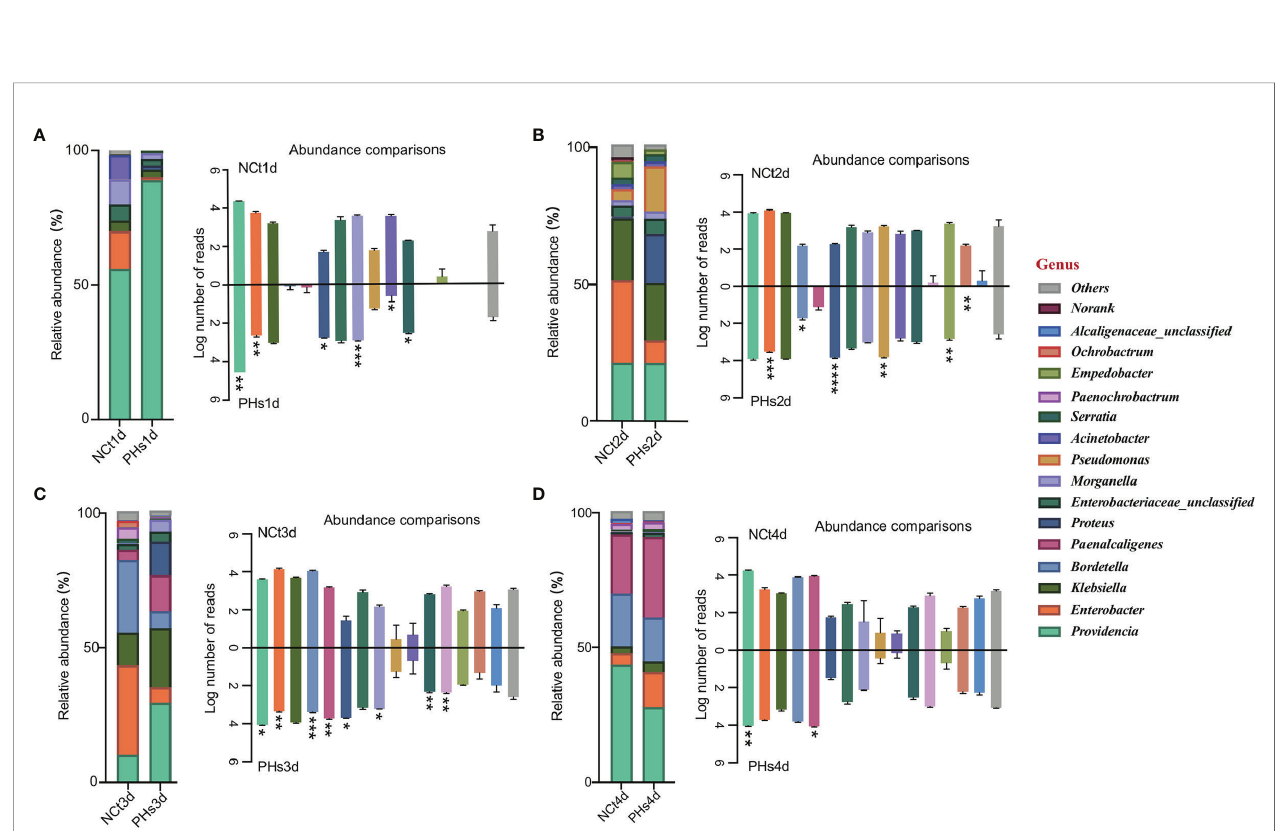
FIGURE 5 | Relative abundances of the 16 most abundant genera of intestinal bacteria in phage-infected house fl y larvae and the control group. Changes in the relative abundances of 16 most abundant genera in different treatments occurred on the 1 st (A) , 2 nd (B) , 3 rd (C) and 4 th (D) days and the key on the left show signi fi cant changes for each genus. Data are shown as the means ± SEM. Repeated measures ANOVA was followed by Sidak correction for multiple comparisons. * P < 0.05, ** P < 0.01, *** P < 0.001, **** P <